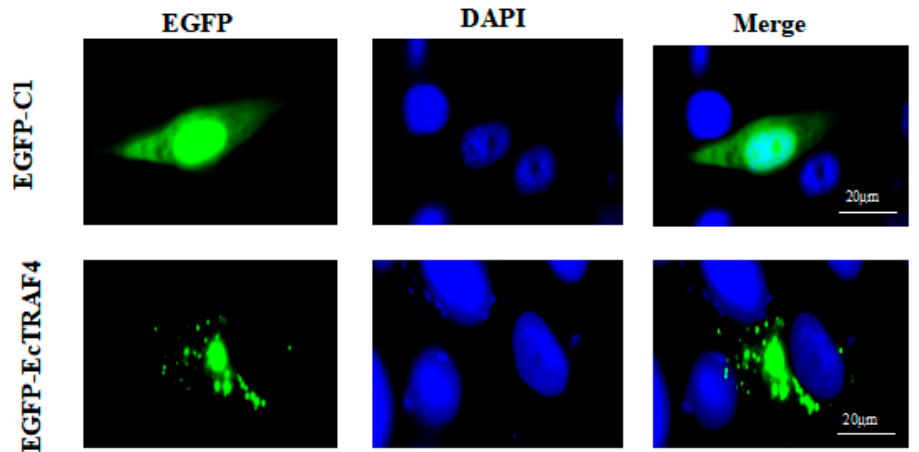
Figure 4. Subcellular localizations of EcTRAF4 in GS cells. GS cells were transfected with the plasmids of pEGFP–C1 and pEGFP–EcTRAF4 separately and then stained with DAPI. Samples were observed under fluorescence microscopy.